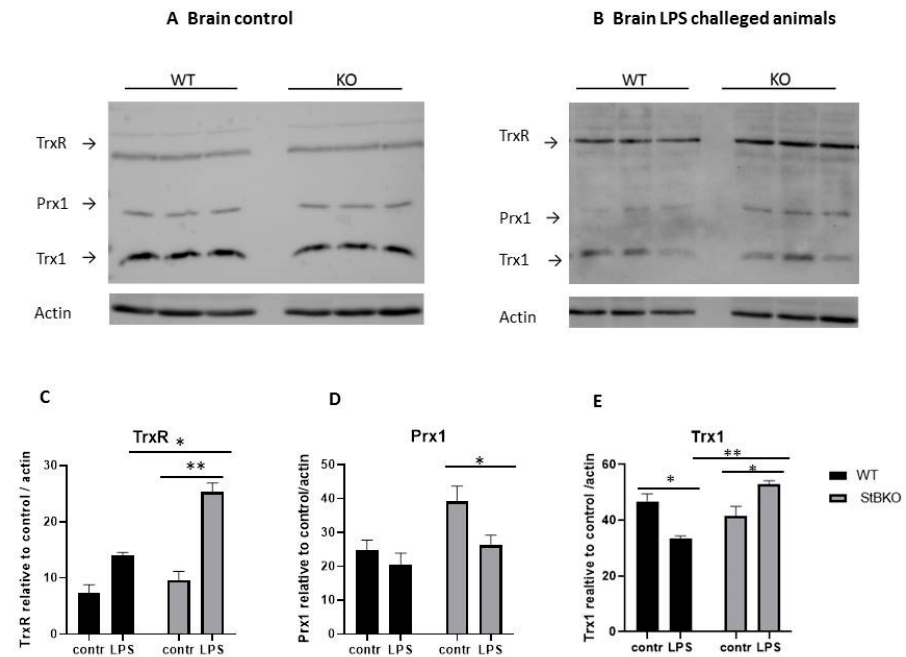
Figure 1. Thioredoxin reductase (TrxR), peroxiredoxin 1 (Prx1) and thioredoxin 1 (Trx1) protein levels in brain of stefin B-deficient (KO) and control (WT) mice (n = 6) after LPS challenge. Age-matched control FVB/N mice (WT) and stefin B-deficient (KO) were left untreated or were injected with LPS (3 mg/kg body weight). 4 h after LPS challenge animals were sacrificed. Brain tissue lysates of control mice ( A ) or LPS injected animals ( B ) were analyzed by Western blots with specific antibodies. Anti β -actin antibodies were used as a loading controls. The levels of TrxR ( C ), Prx1 ( D ) and Trx1( E ) in brain lysates from wild type (WT) and stefin B-deficient (KO) mice in comparison to β -actin controls were quantified by ImageJ. Statistically significant differences vs. control group, * p < 0.05. ** p ≤